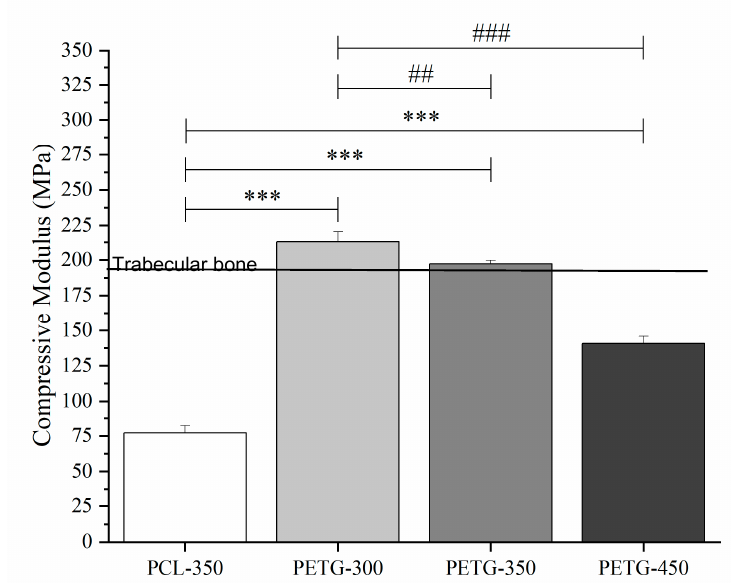
Figure 4. Compression modulus for the PCL scaffold and PETG scaffolds with different pore size. *** p < 0.001 compared with control (PCL), ## p < 0.01 and ### p < 0.001 compared with different pore size.